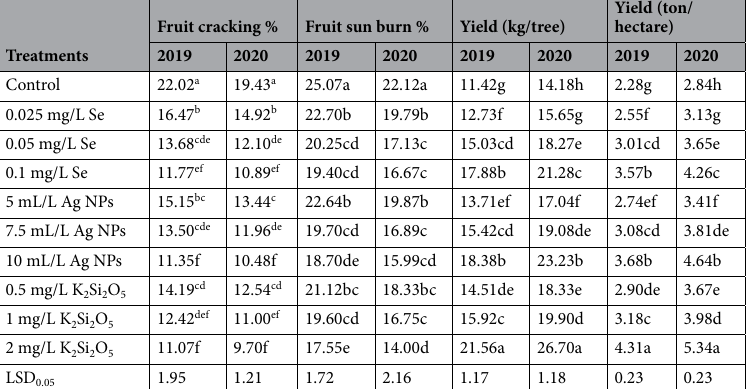
Fruit cracking % Fruit sun burn Treatments